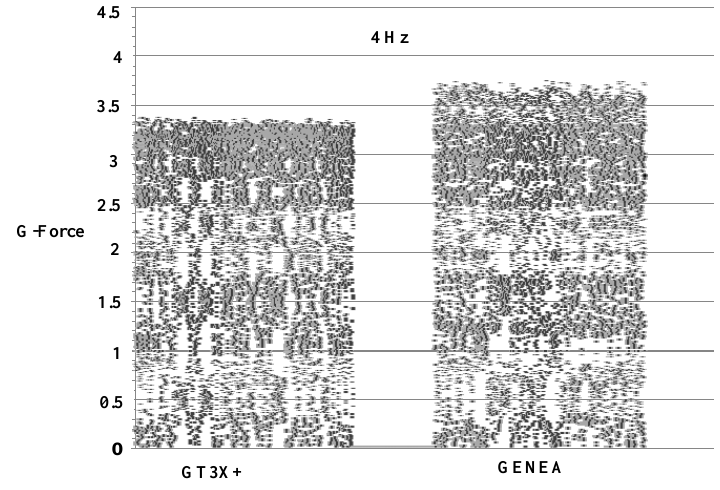
Figure 3. Comparison of absolute raw acceleration between the GT3X+ and GENEA at 4 Hz for the x-axis during one trial of shaker